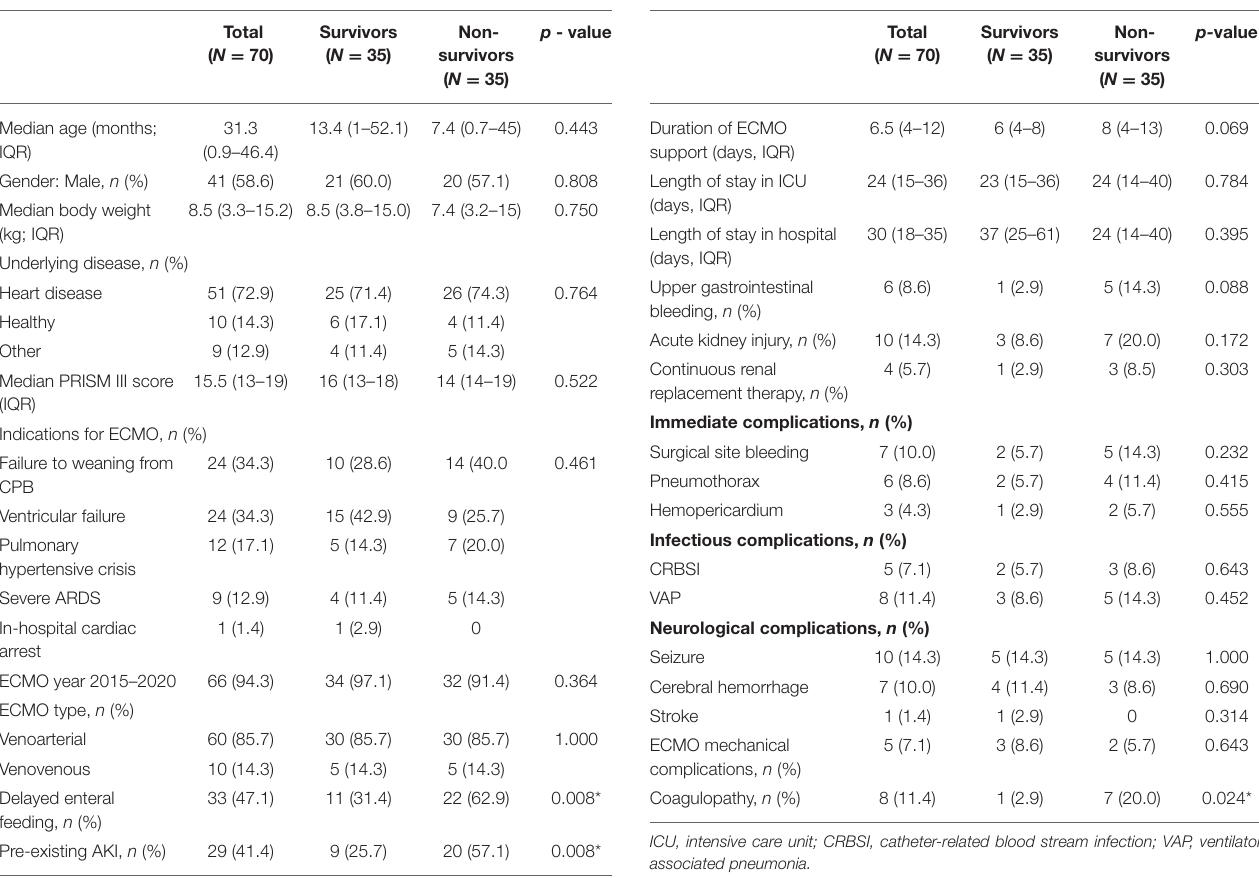
TABLE 1 | Baseline characteristics. TABLE 2 | Outcomes and complications of ECMO.